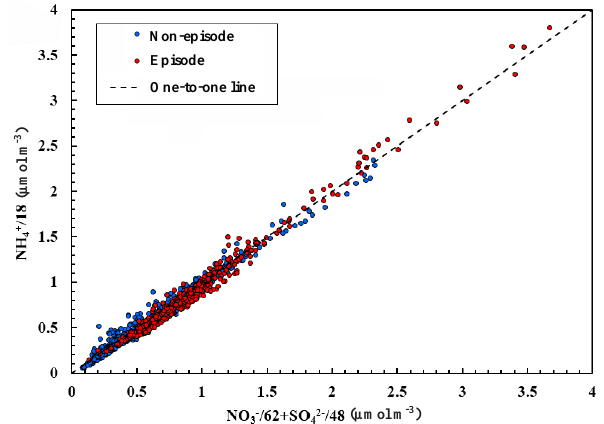
Figure 4. Relative abundance of molar charges of PM 2 . 5 during autumn in